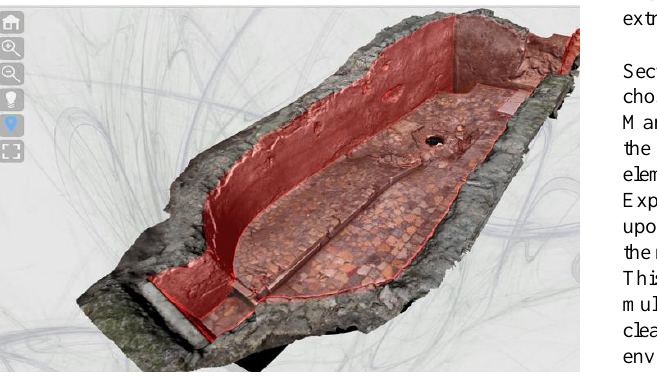
Fig. 9. 3D Model Hotspots, High Resolution Images